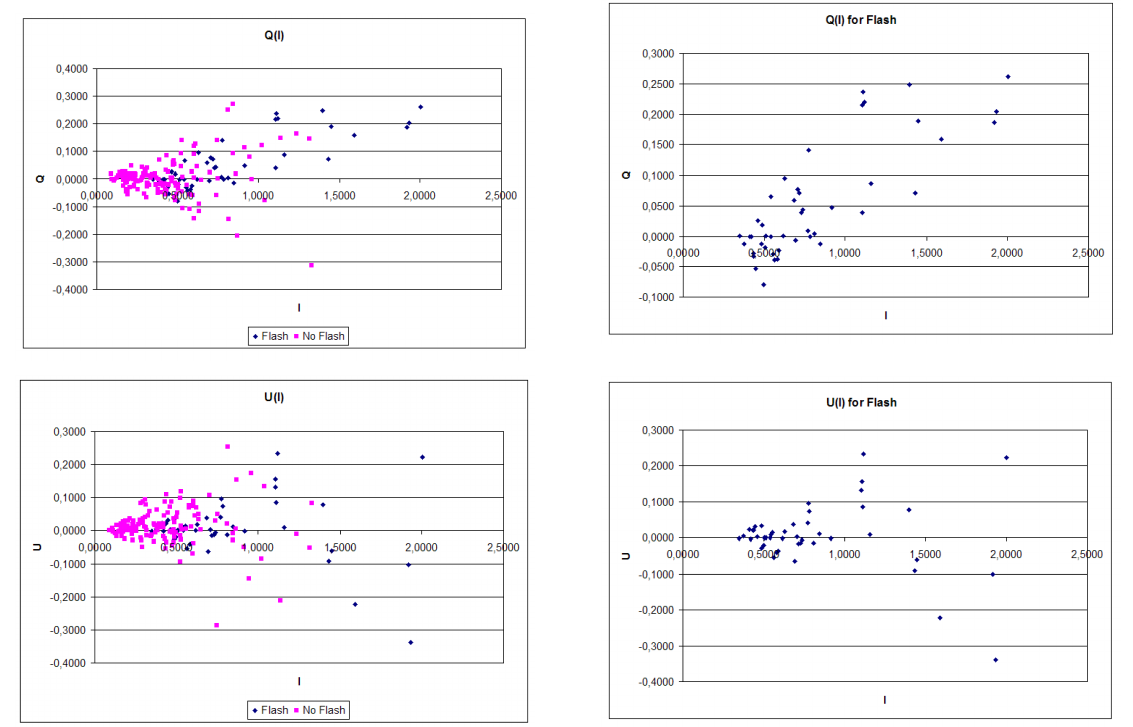
Figure 9. Q ( I ) and U ( I ) ( left ) and Q ( I ) and U ( I ) for the flash ( right ) at the third period.